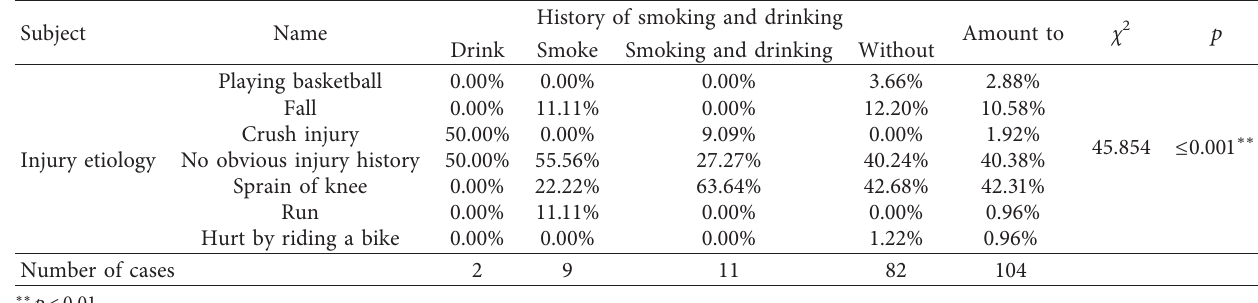
Figure 1: Injury etiology and injury site. Table 6: Cross-over (chi-square) analysis.